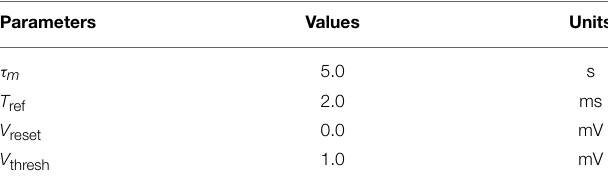
TABLE 1 | Default parameters of the Leaky Integrate-and-Fire Model used in